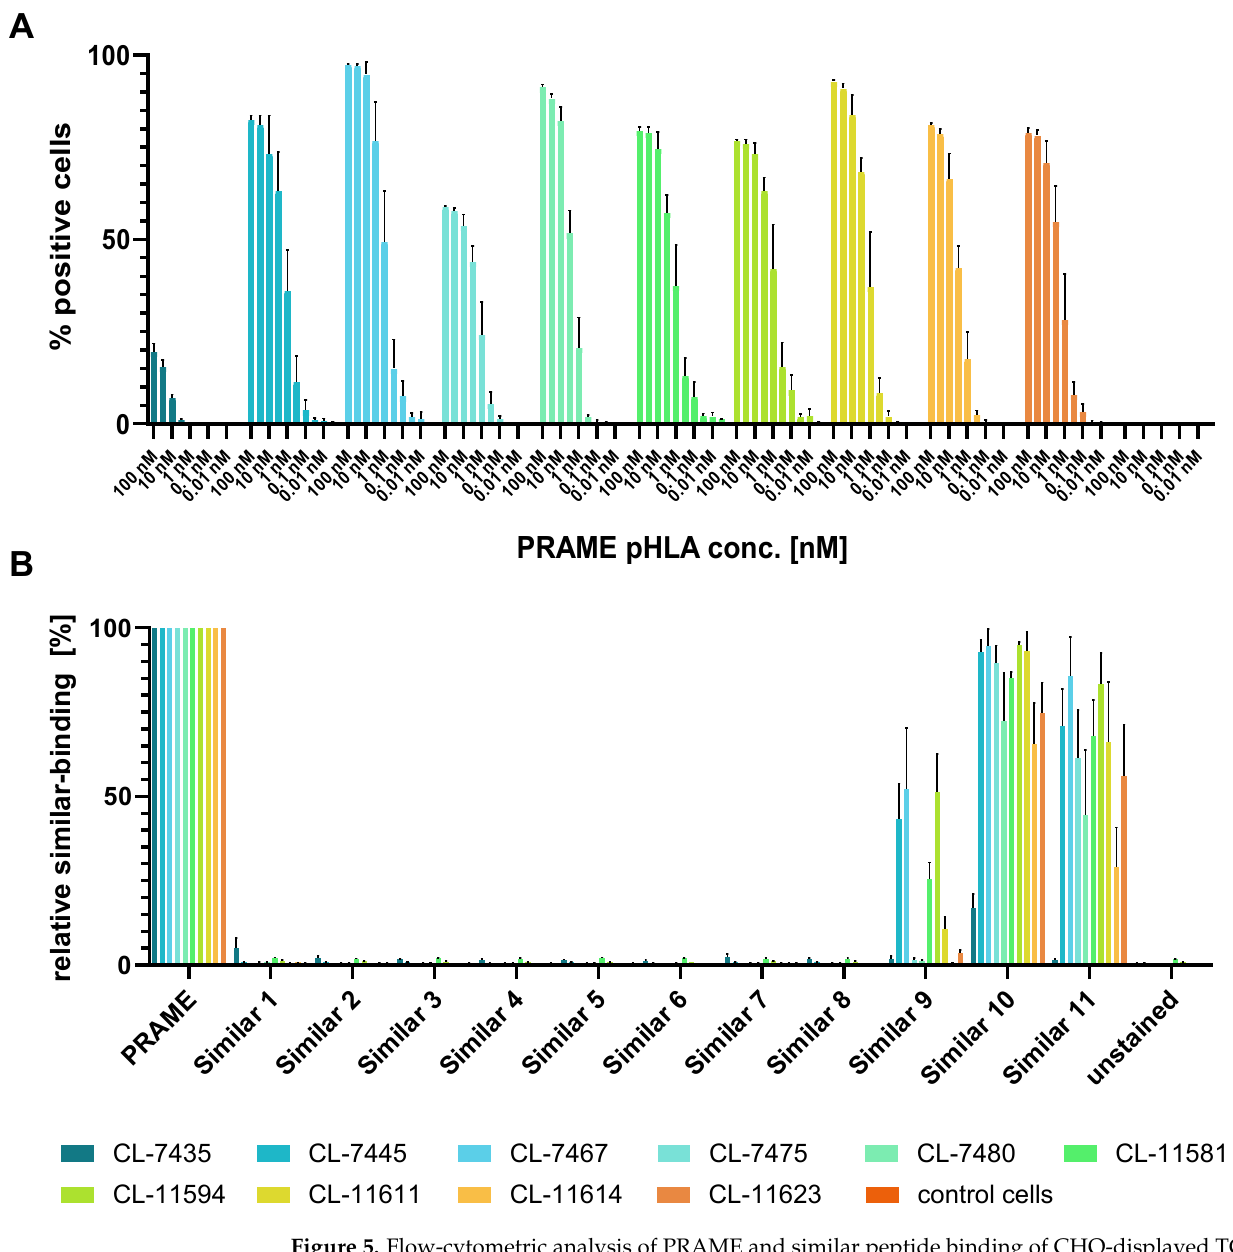
Figure 5. Flow-cytometric analysis of PRAME and similar peptide binding of CHO-displayed TCER candidates. ( A ) Target binding was analyzed with PRAME pHLA monomer applied at concentrations ranging from 100 nM to 10 pM, with √10 diluting steps, resulting in nine different measured concentrations. ( B ) Binding of TCER candidates to 10 nM similar peptide tetramers comprising each of the 11 different similar peptides (Table 1) in relation to the 10 nM PRAME peptide tetramer. Each datapoint represents the mean of triplicate measurements with the respective standard deviation (SD).